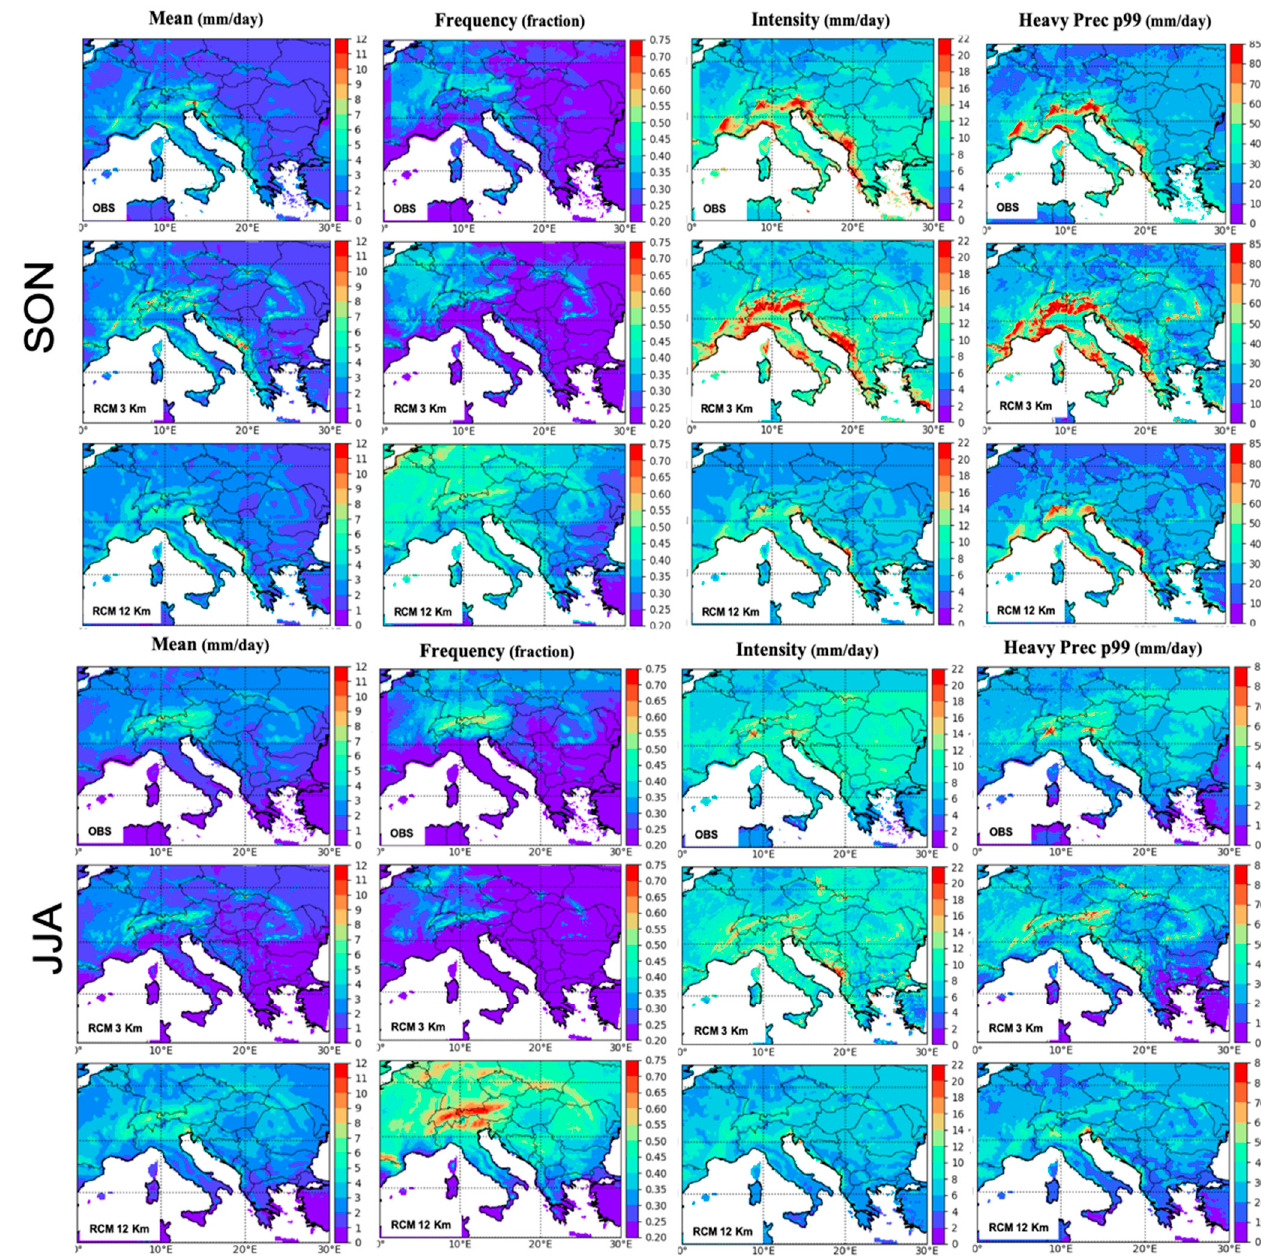
Figure 6. Seasonal mean of analysed indices (from left to right: mean precipitation, precipitation frequency, precipitation intensity, and heavy precipitation (defined as 99th percentile)) calculated for daily precipitation in the autumn (SON) and summer seasons (JJA). The results were obtained from all the observations (OBS) in Table 1 for CP-RegCM4 (3 km) and RegCM4-NH (12 km) model simulations.